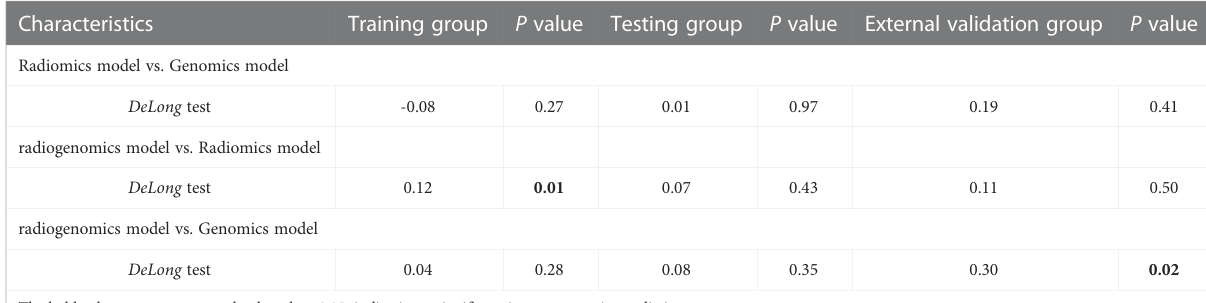
TABLE 3 Delong test for prediction improvements of radiogenomics model in the training, testing and external validation groups.